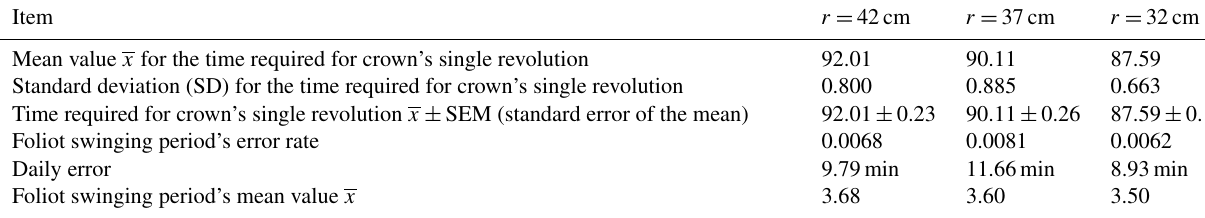
Table 5. Foliot swinging period’s experimental test and calculation results. Item r =